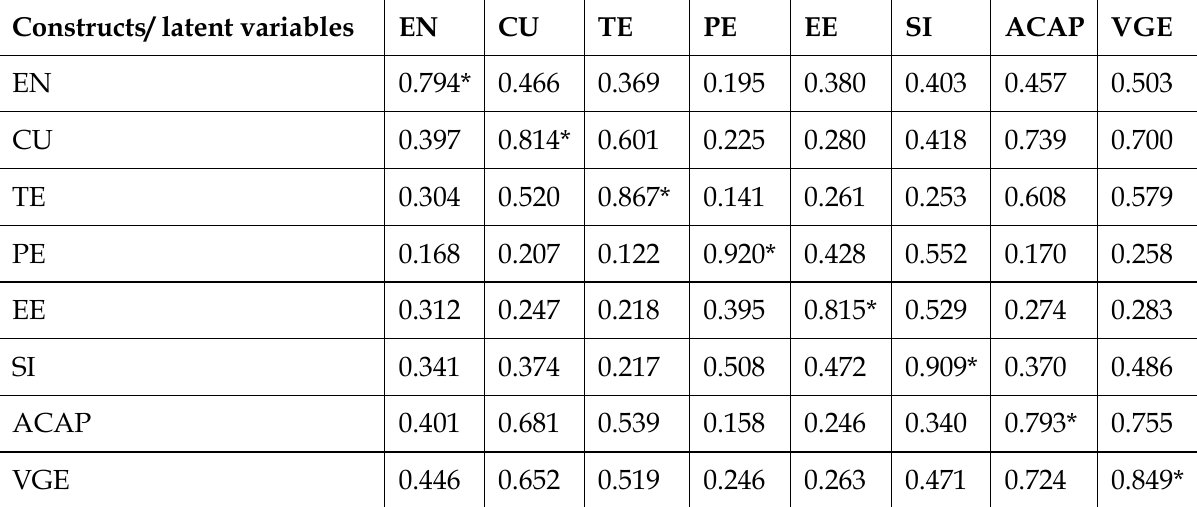
Table 6: Discriminant validity Constructs/ latent